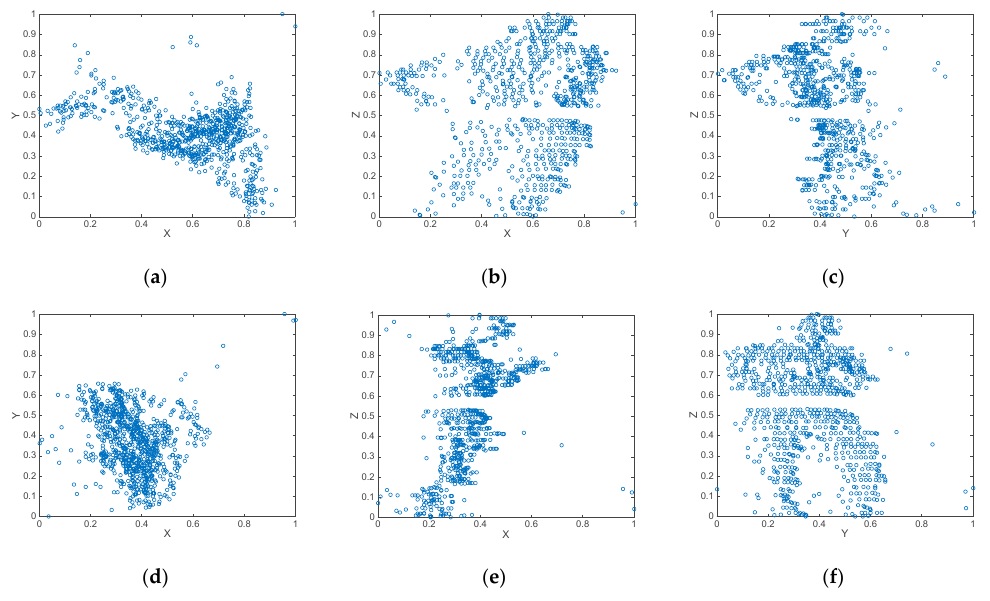
Figure 7. Normalized XY, XZ and YZ axonometric projections of two pedestrian samples: ( a – c ) pedestrian one; ( d – f ) pedestrian two. By applying different coefficients to the normalized data, while keeping the aforementioned proportions, we can generate several binary images. But these images are only composed of dots (the points where a laser beam hit an object), see Figure 8a–f.